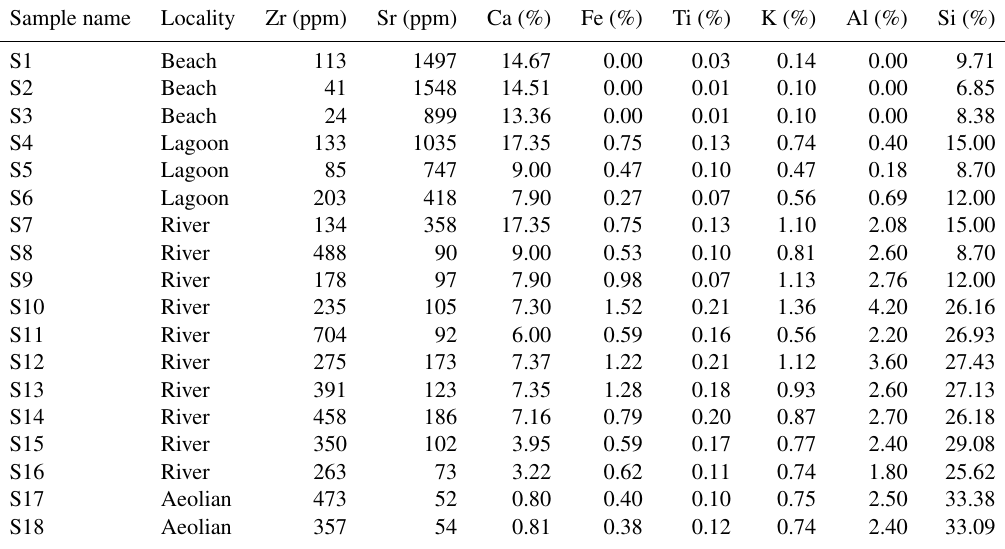
Table 3. XRF analysis results of the major and trace elements in studied